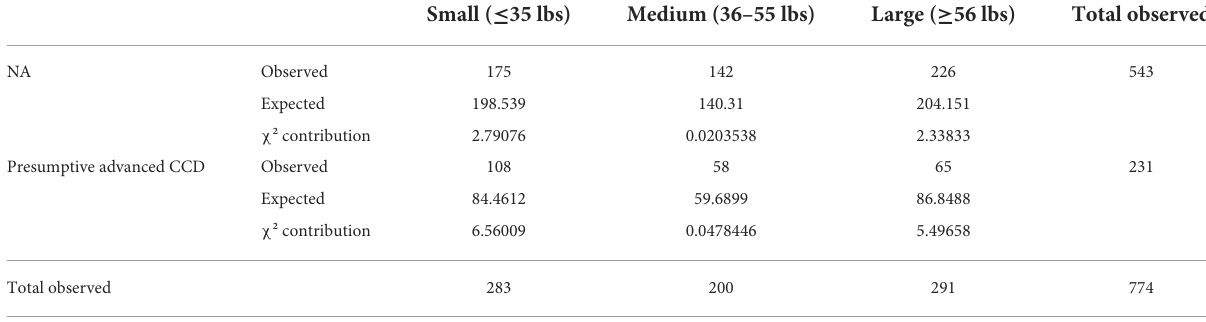
TABLE 4 Evaluation of the association of breed size between NA and presumptive Advanced CCD groups using the chi-square test [degrees of freedom: 2; chi-square ( χ ² ): 17.2539; p -value: